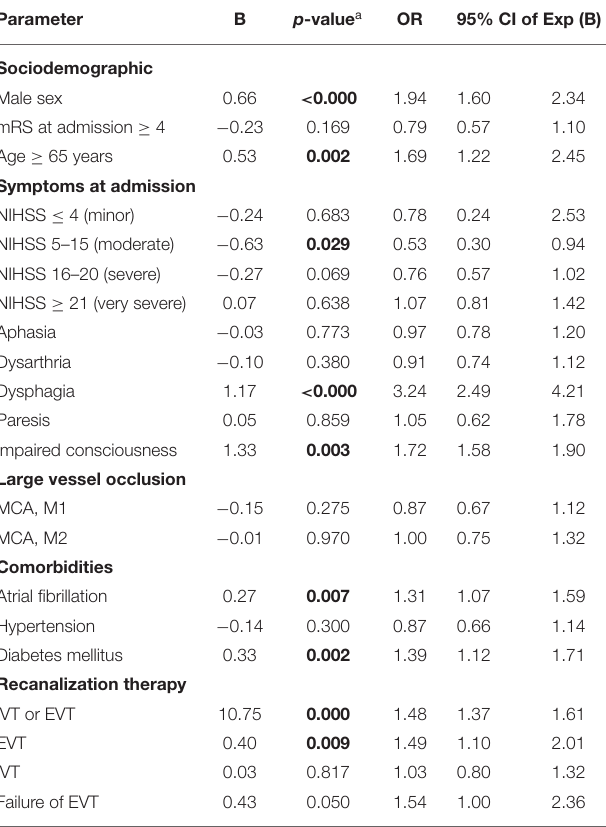
TABLE 2 | Multivariate analysis of possible predictive factors for developing poststroke pneumonia after large vessel